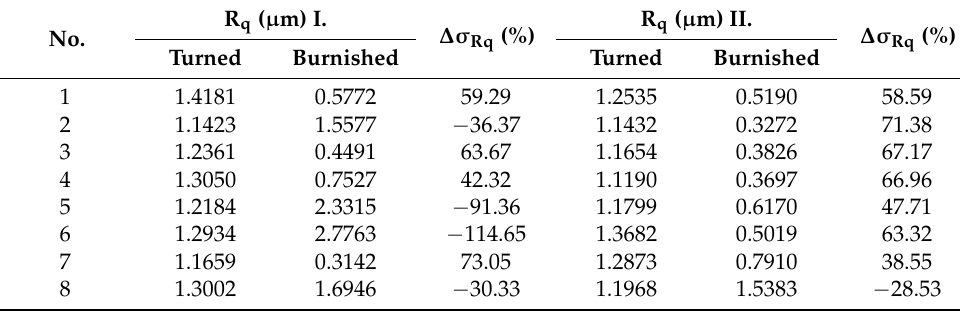
Table 5. The measured values and the calculated improvement ratios for R q